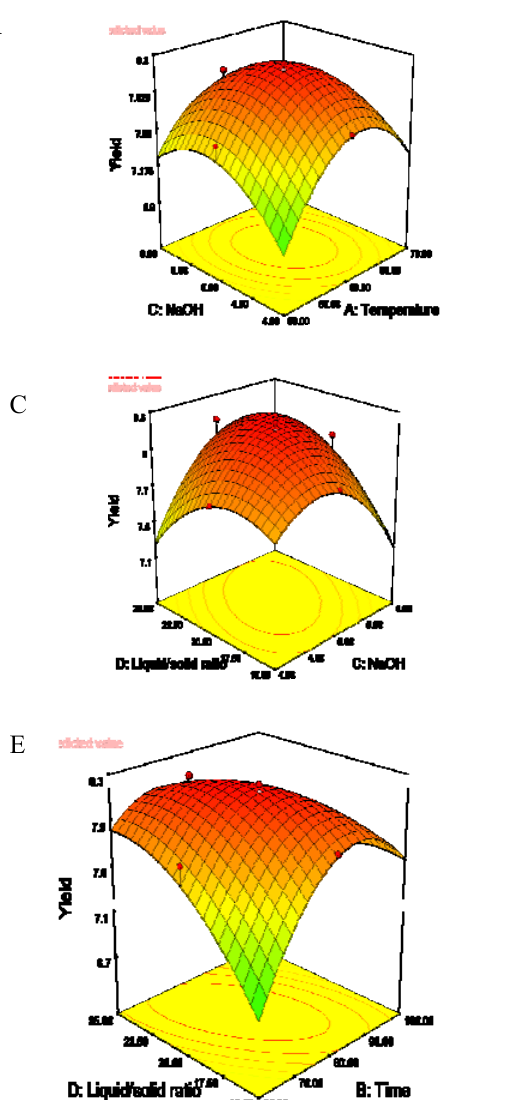
Figure 1. The surface and contour plot of polysaccharide yield as affected by extraction temperature (X1), extraction time (X2), NaOH concentration (X3) and ratio of liquid to solid (X4). Where (A) is X1 and X3 (liquid/solid ratio 20:1,time 80 min); (B) is X3 and X2(alkali/solid ratio 20:1,temperature 60 ºC); (C) is X4 and X3 (temperature 60 ºC, time 80min); (D) is X3 and X2 (NaOH 5.0%,time 80 min).,(E) is X4 and X2(temperature 60 ºC,NaOH 5.0%) ;(F) is X1 and X2 (liquid/solid ratio 20:1, time 80